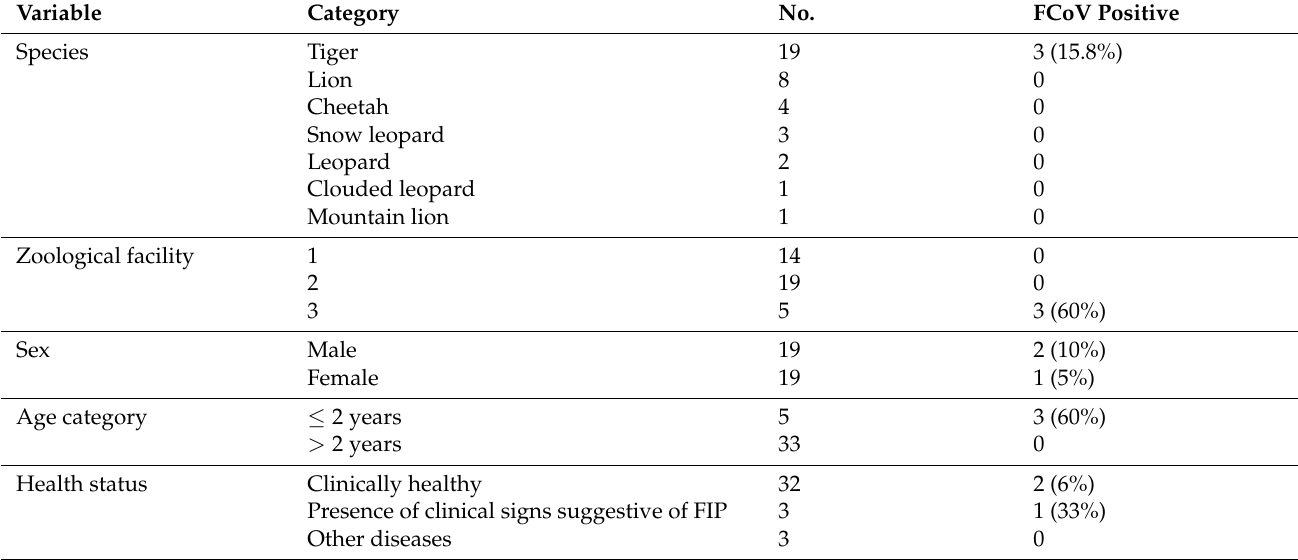
Table 3. Number and percentage of non-domestic felids with FCoV RT-qPCR positive results accord- ing to species, facility, sex, age, and health